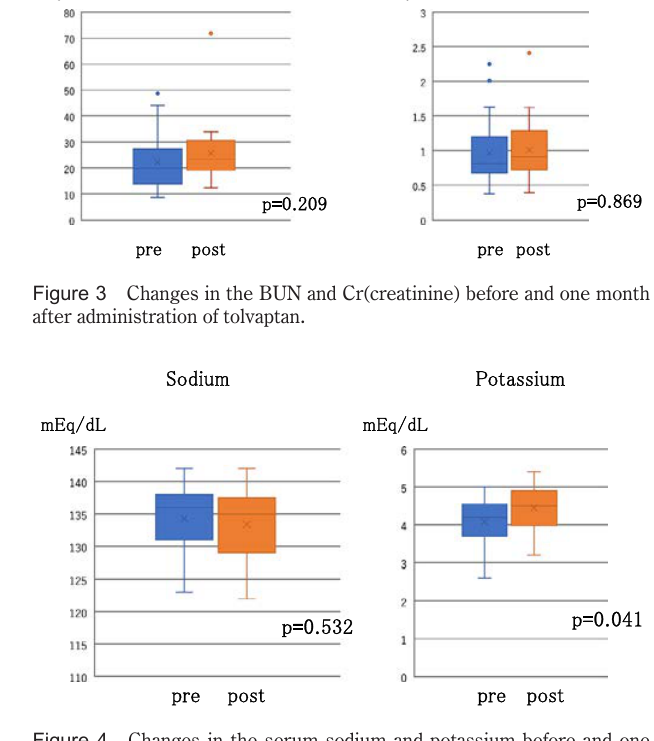
Figure 4 Changes in the serum sodium and potassium before and one month after administration